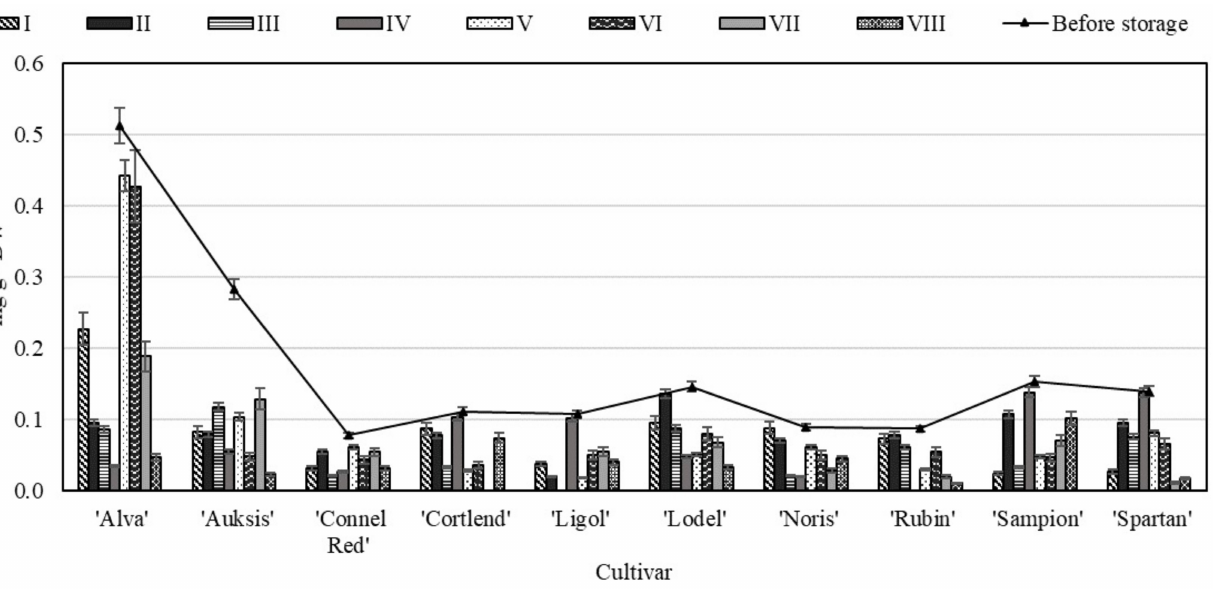
Figure 11. Changes in the total amount of triterpenic compounds in the apple flesh samples before and after storage in CA. Like in the whole apple and apple peel samples, ursolic acid was the predominant compound among all the determined triterpenic compounds. The study showed that before storage the highest amount of ursolic acid (0.46 ± 0.04 mg g − 1 ) was determined in the apple flesh samples of the ‘Alva’ cultivar, and the lowest content (0.06 ± 0.01 mg g − 1 )—in the samples of the ‘Connel Red’ cultivar (Figure 12). Researchers have evaluated that the greatest amount of ursolic acid (0.25 mg g − 1 ) was detected in the apple flesh samples of the ‘Rajka’ cultivar [52].